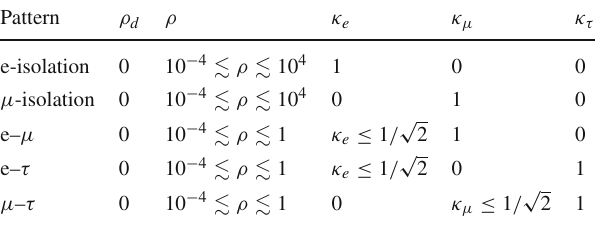
Table 4 Defining values and/or experimentally bound ranges for the parameterization of (25), in the normal hierarchy scenario. As noted in the text, three-columned patterns are reduced to their two-columned cousins upon SU(2) symmetry considerations (cf. Sect. 3.3), and hence we do not need to fit such matrices Pattern ρ d